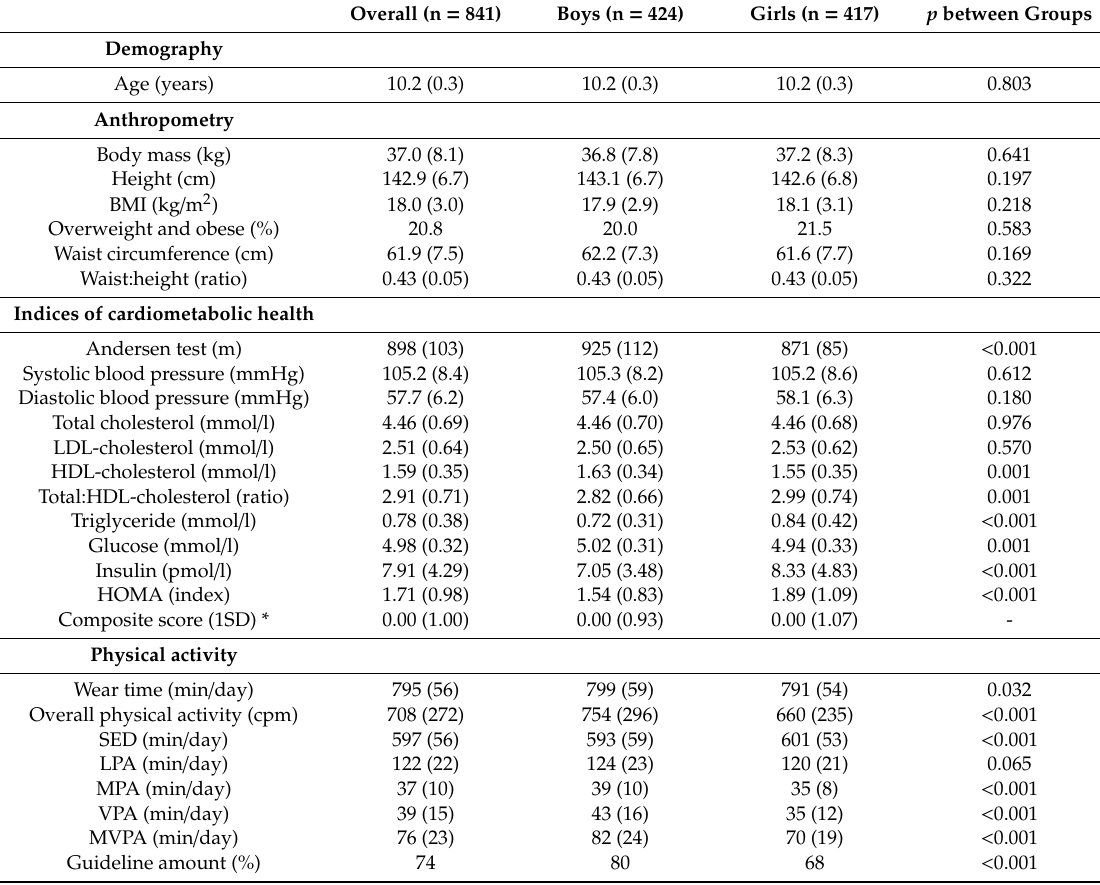
Table 1. Children’s